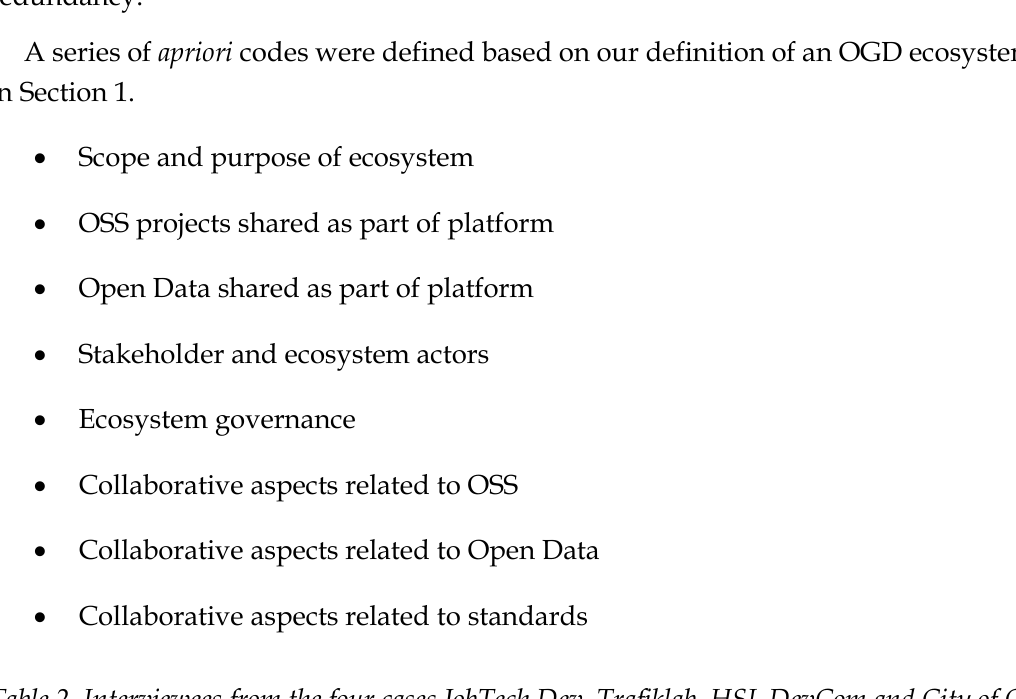
Table 2. Interviewees from the four cases JobTech Dev, Trafiklab, HSL DevCom and City of